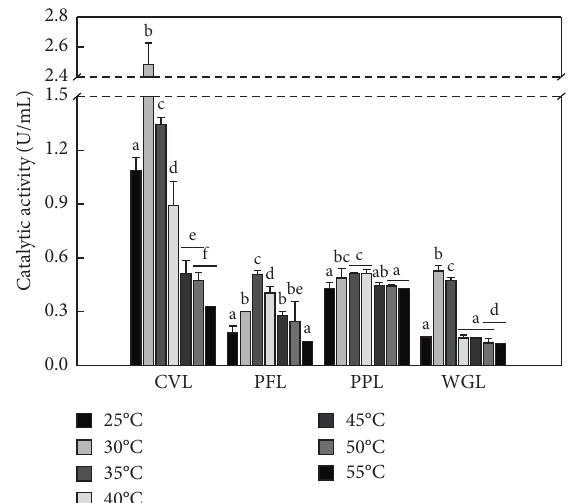
Figure 3: Effects of operating temperature on the catalytic activity of lipases against p -nitrophenyl palmitate as a substrate. The op- erating temperature was in the range of 25–55 ° C. Error bars in- dicate the standard error of the mean. Superscripts (a–f) above the bars denote significant differences in catalytic activity ( p < 0 . 05, Duncan’s multiple range test on ANOVA). CVL, Chromobacterium viscosum lipase (0.01mg/mL); PFL, Pseudomonas fluorescens lipase (0.001mg/mL); PPL, porcine ( Sus scrofa ) pancreatic lipase (10mg/ mL); WGL, wheat germ ( Triticum aestivum ) lipase